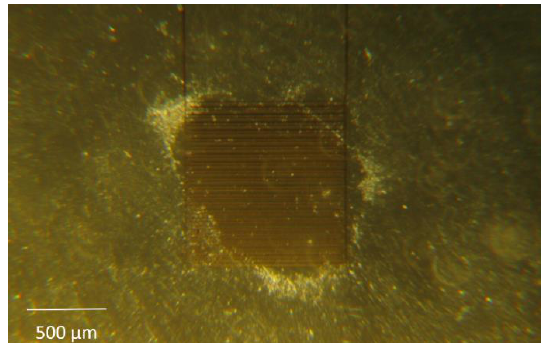
Figure 6. Exemplary picture of a flexible, printed electrode (center) after nsPEF treatment. The cell layer around the electrode is still as dense as before pulsing. However, most of the interdigital electrode area is almost free of fibroblasts and cell clusters formed at the electrode ’ s edge.